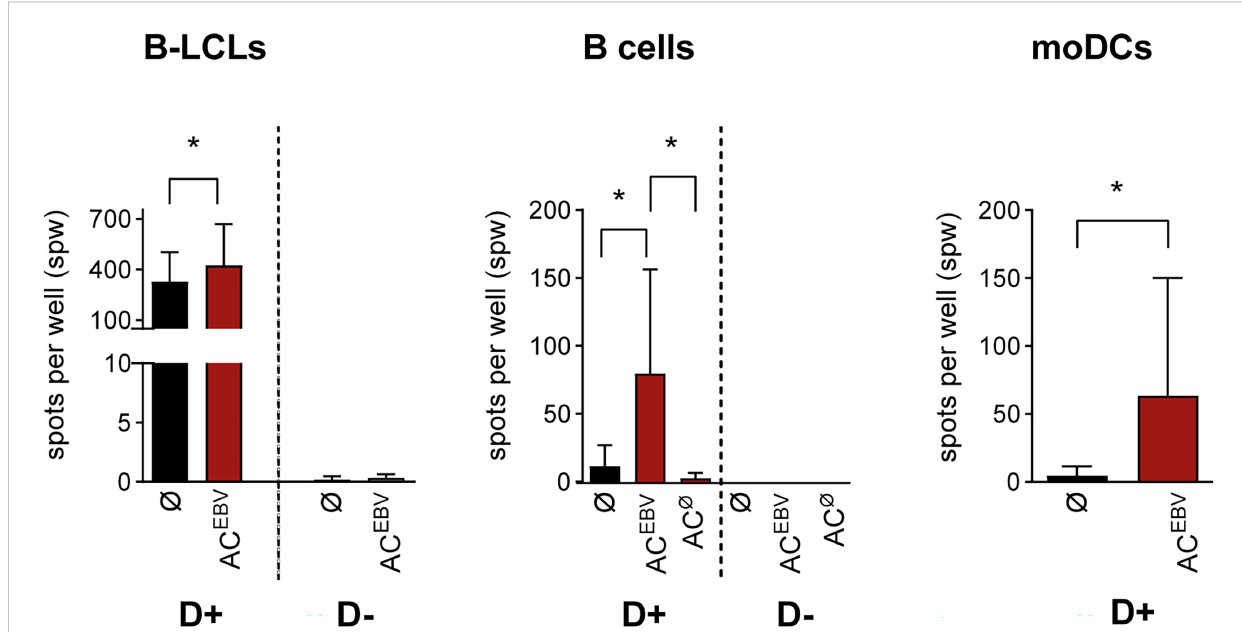
FIGURE 3 EBV-speci fi c T-cell stimulation through AC EBV -derived antigens presented by human APCs. EBV-speci fi c T-cell responses examined in EBV- seropositive (D+, n=7) and -seronegative (D-, n=3) donors by IFN- g EliSpot assay using CD3 + T cells co-cultured with either autologous AC-loaded B-LCLs (effector to target (E:T) ratio 10:1, 2.5 x 10 5 CD3 + T cells), B cells (E:T ratio 4:1, 2.5 x 10 5 CD3 + T cells) or moDCs (E:T ratio 4:1, 1 x 10 5 CD3 + T cells) as APCs (AC EBV /AC ø , red bars). T-cell co-cultures with unloaded APCs (Ø, black bars) in same cell numbers and ratios served as controls. All spot counts are mean values of duplicate wells and expressed as spot-forming unit per well (spw). Spot counted for CD3 + T cells or APCs alone were subtracted from those measured in T-cell co-cultures. Results of independent experiments are expressed as mean ± SD. Statistical signi fi